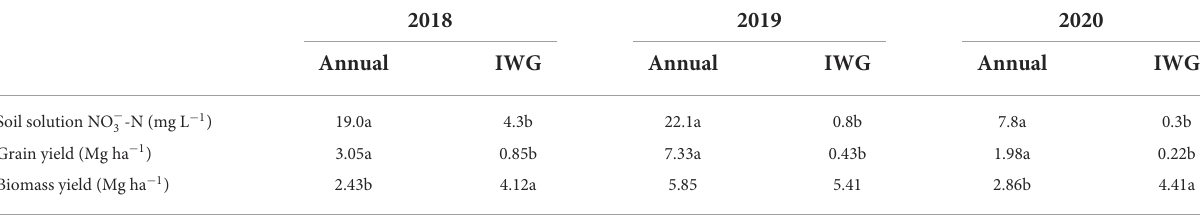
TABLE 2 Average soil solution NO − 3 -N, grain, and biomass yields in the annual and IWG systems in 2018, 2019, and 2020.